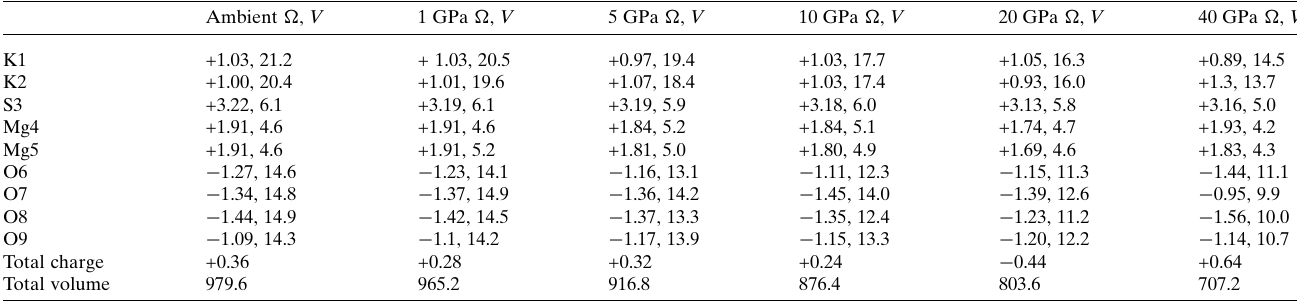
Table 3 Net atomic charges (cid:3) (e (cid:4) ) and volumes V [A˚ 3 ] of atomic basins. Ambient (cid:3) ,